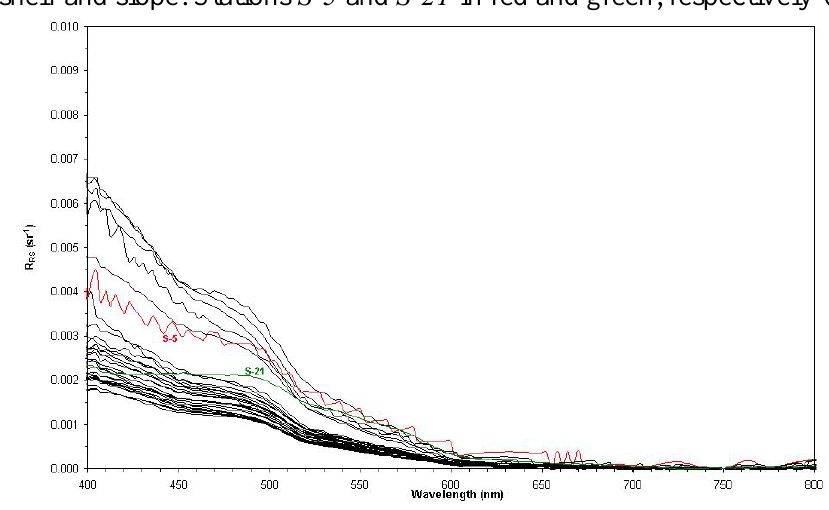
Figure 5. Surface remote sensing reflectance spectra obtained by above-water radiometry during the cruise FITOSAT I cruise, November 2004, in the Brazilian Southeastern continental shelf and slope. Stations S-5 and S-21 in red and green, respectively (see text).